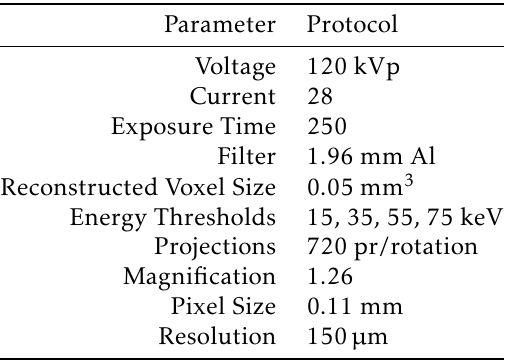
Table 1: Geological sample scanning protocol